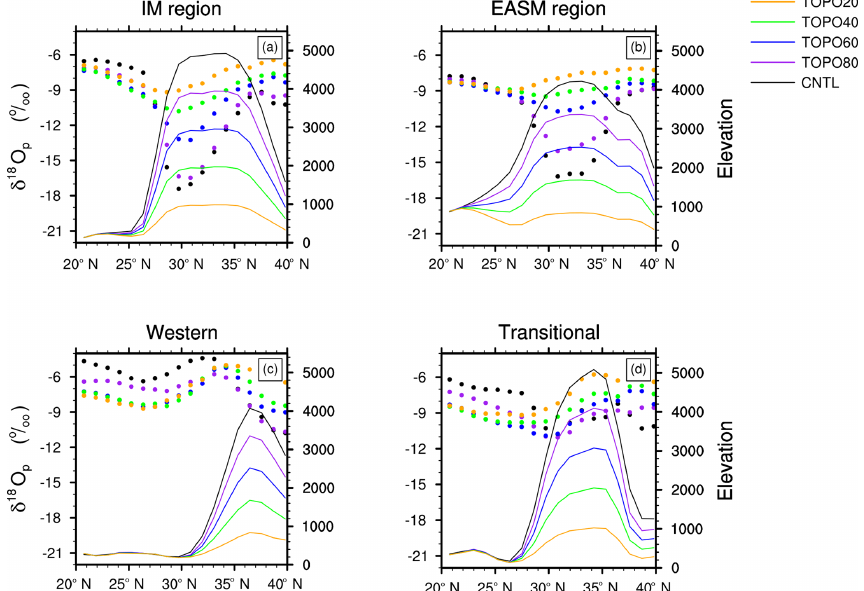
Figure 4. Annual-mean precipitation-weighted δ 18 O p (filled circles) and surface elevations (lines) along latitudinal transects for the (a) IM, (b) EASM, (c) western, and (d) transitional regions. These values represent zonal-average values over the specific region.